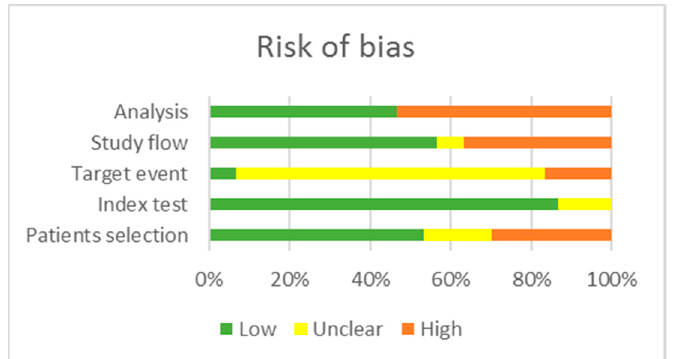
Figure 2. Risk of bias of the included studies.